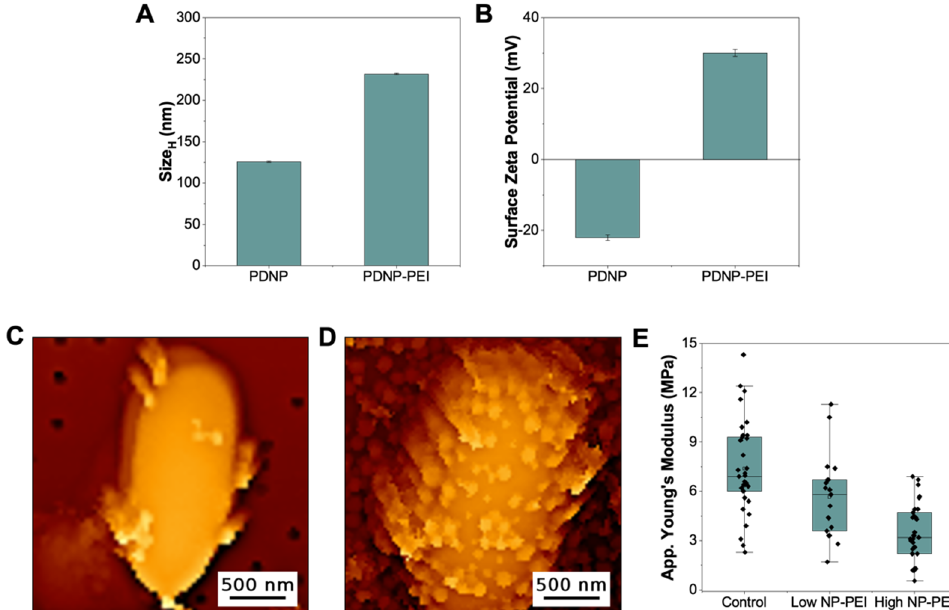
Figure 4. ( A ) Hydrodynamic diameter ( Size (cid:2892) ) and ( B ) surface zeta potential of polydopamine nanoparticles (PDNP) before and after functionalization with PEI (PDNP-PEI). Topography images of E. coli pre-treated with ( C ) 4 μg/mL ( n = 20) and ( D ) 100 μg/mL ( n = 31) PDNP-PEI. ( E ) The distribution of the average apparent Young’s modulus of PDNP-PEI treated bacteria (low NP-PEI = 4 μg/mL and high NP-PEI = 100 μg/mL PDNP-PEI) relative to the untreated bacteria (control).